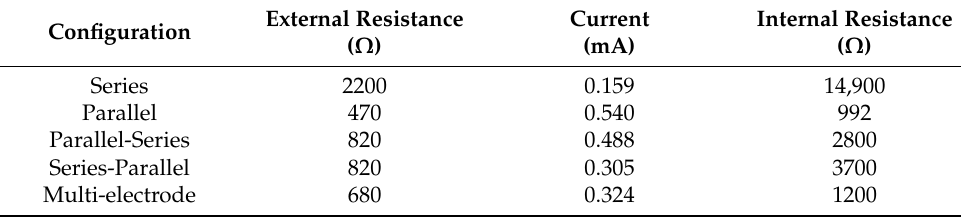
Table 5. Power overshoots conditions.